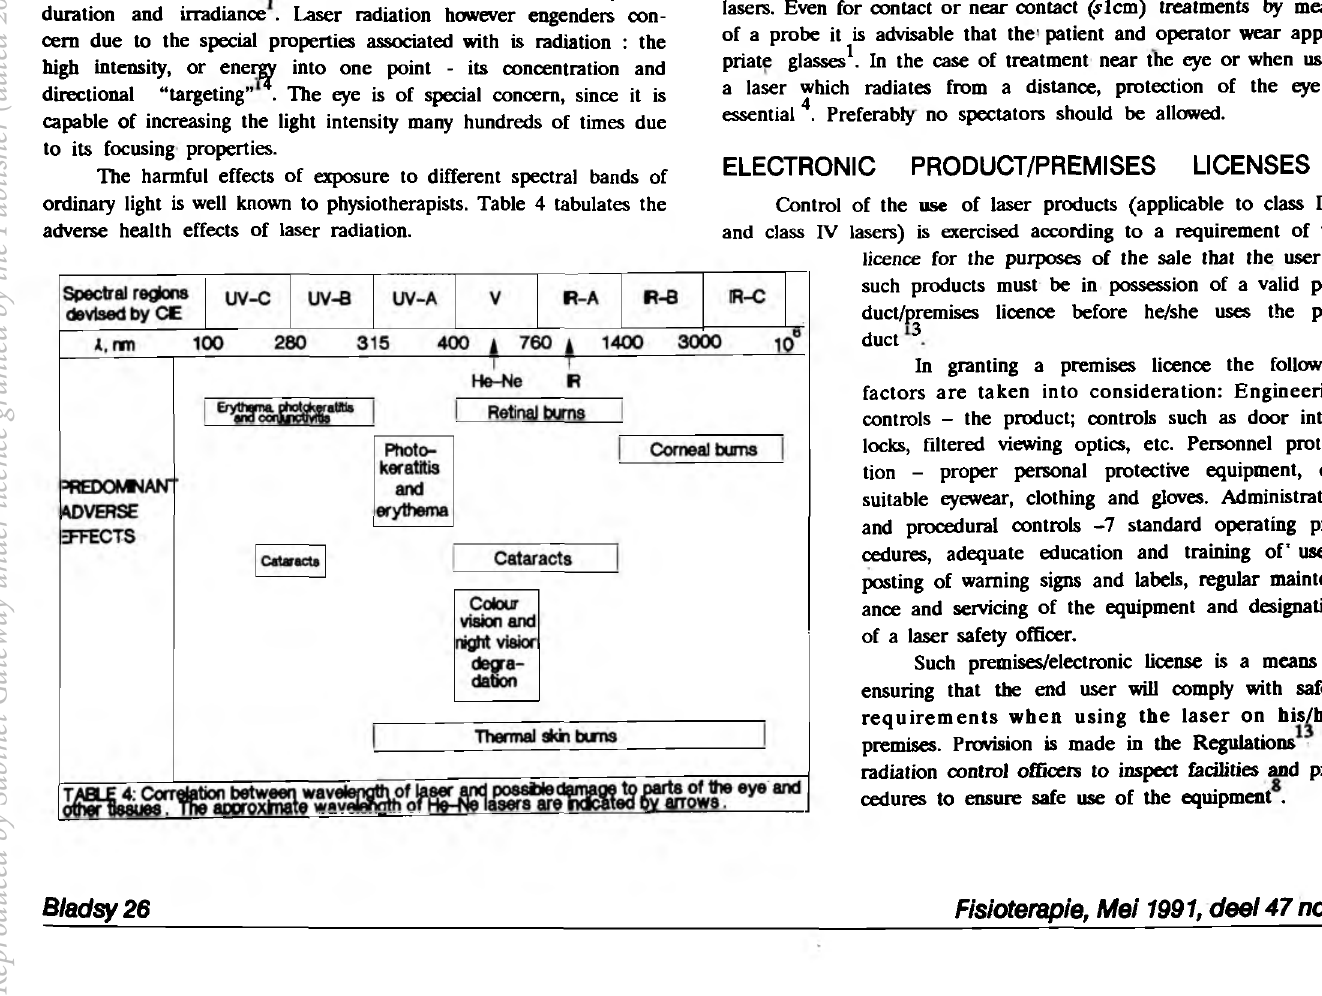
TABLE 5: RISK ACCORDING TO LASER